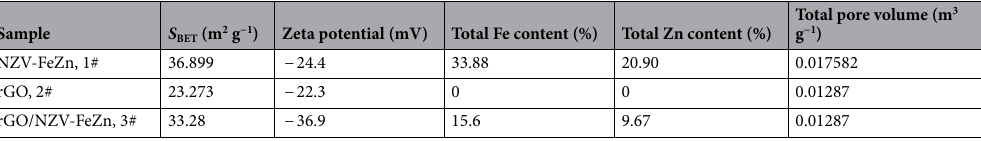
Table 3. Selected textural properties of adsorbents.